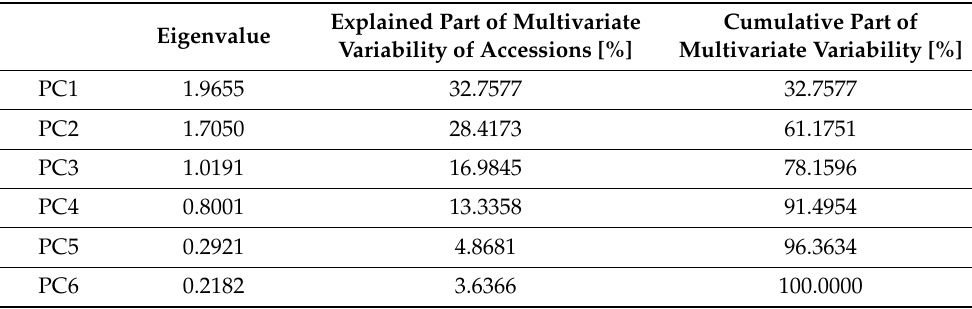
Table 8. The values of the correlation between PC1, PC2, and the variables used to build the model. PC1 PC2 Variables Correlation p -Value Correlation p -Value water temperature ( ◦ C) 0.8287 wind speed (km/h)